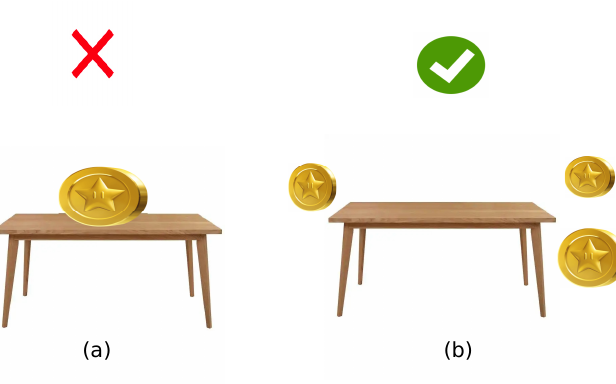
Figure 13. Location of virtual elements. ( a ) Unsafe location. ( b ) Safe location.